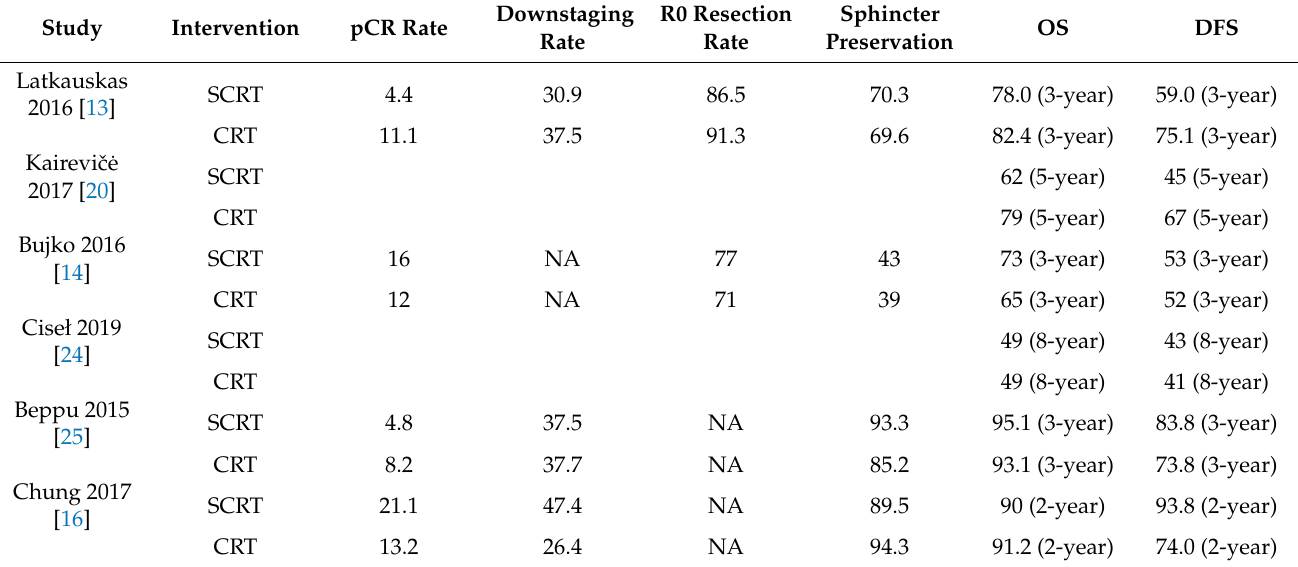
Table 3. Summary of the outcomes from the including